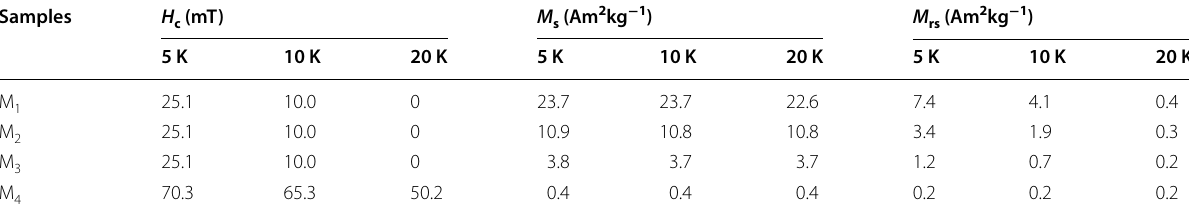
Table 2 Hysteresis parameters obtained from low-temperature measurements